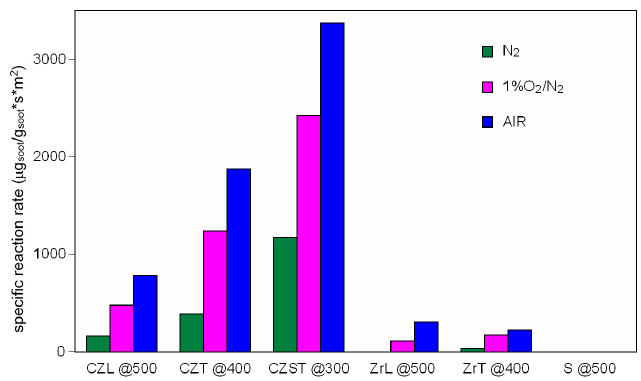
Figure 7. Specific reaction rate for different contact conditions and different reaction atmospheres.